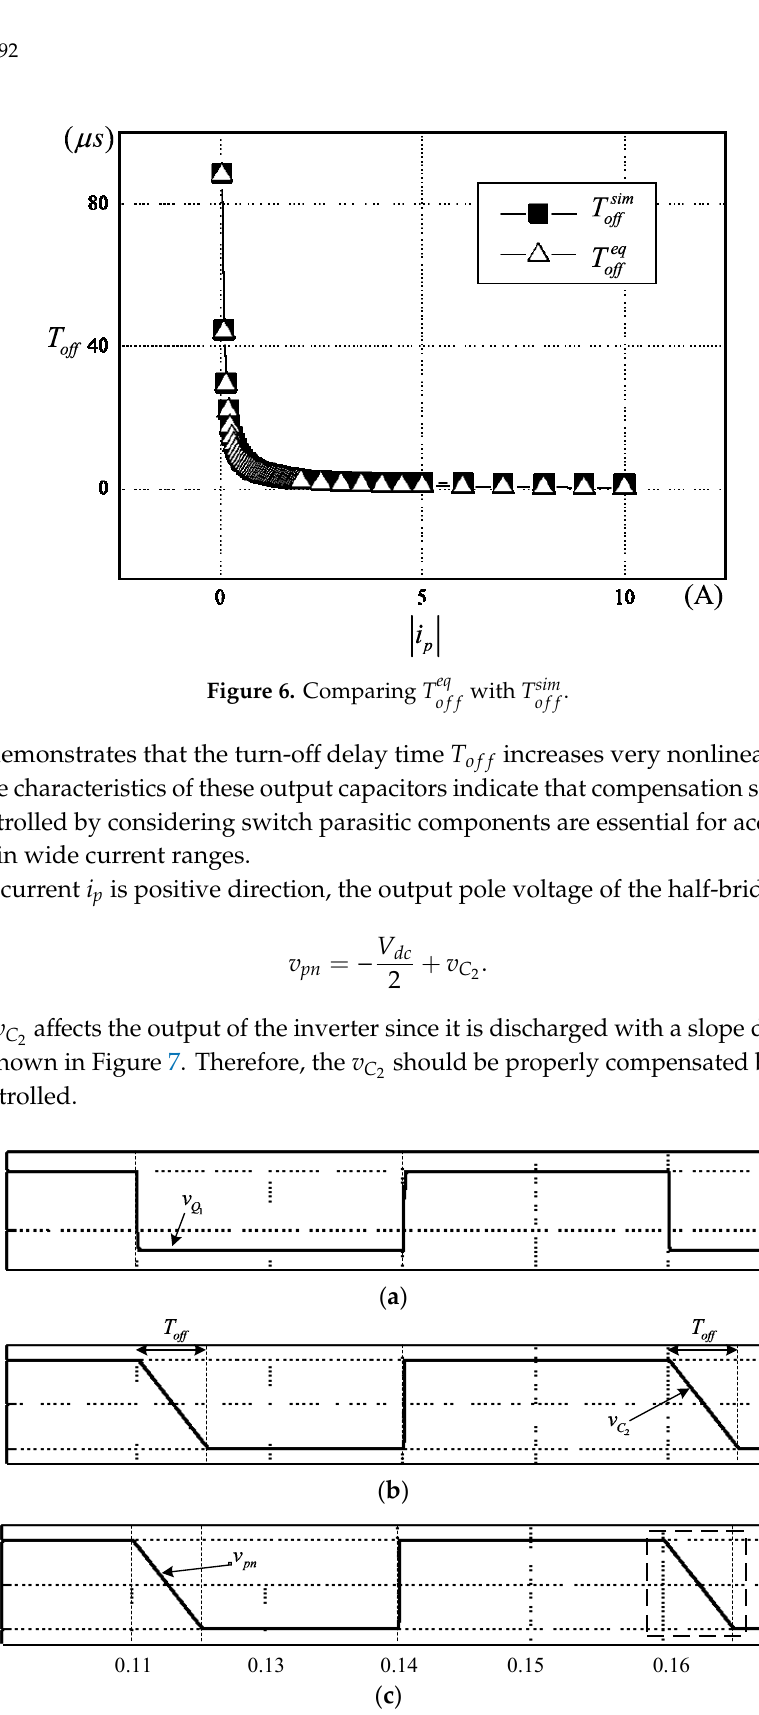
Figure 7. Simulation results of Figure 5; ( a ) gate voltage v Q ( c ) inverter pole voltage v pn ;